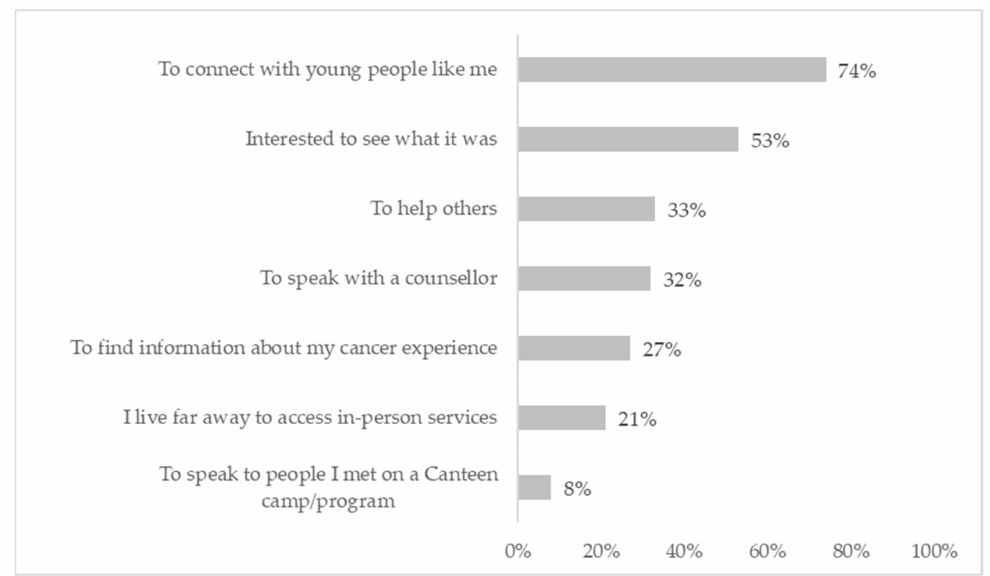
Figure 4. Reasons for joining Canteen Connect version